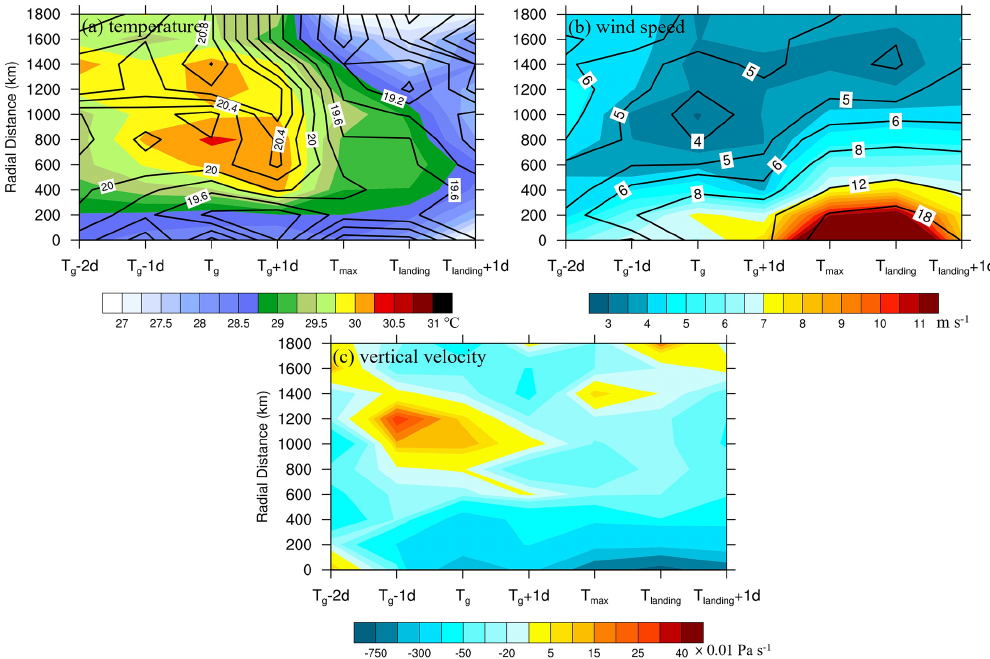
Figure 3. The (a) 10m (shaded) and 850hPa (contour lines) air temperature (in ◦ ), (b) 10m (shaded) and 850hPa (contour lines) wind speed (in ms − 1 ), and (c) 500hPa vertical wind velocity (0.01Pas − 1 ; positive values for downward air motions and vice versa) at daytime (14:00LST) based on the MERRA-2 reanalysis at different radial distances and typhoon developmental stages averaged over the large ensemble of typhoons for the 2014–2018